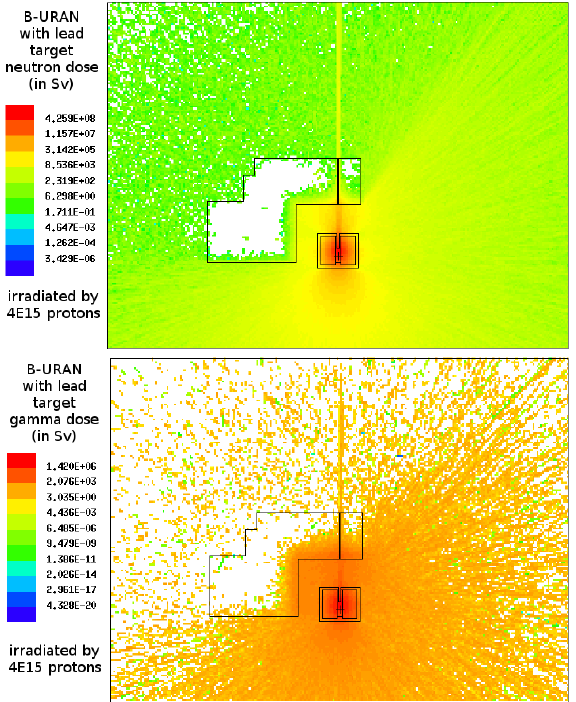
Figure 9. Neutron and gamma dose around B-URAN experimental assembly with lead target, at level of proton beam, irradiated by 4E15 protons (created by